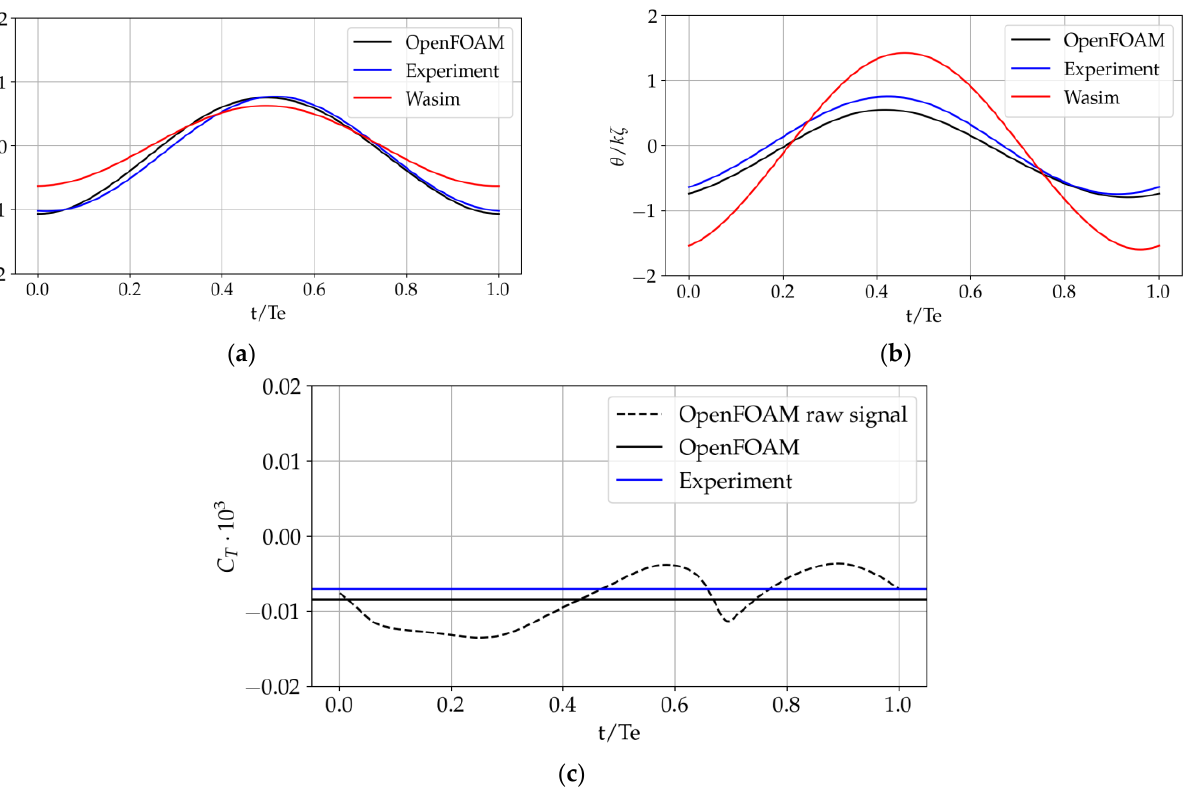
Figure 24. Time histories for case 3 of the KRISO containership: nondimensional ( a ) heave, ( b ) pitch, ( c ) total resistance.